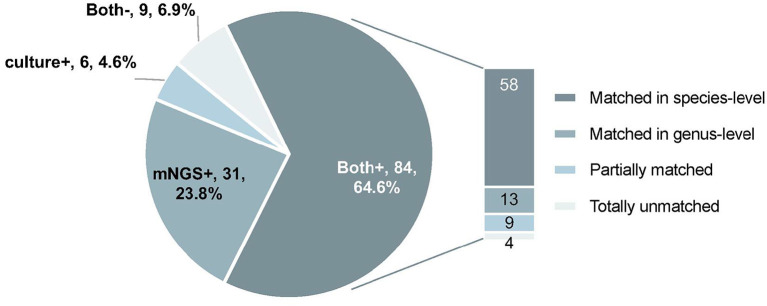
The concordance of results between metagenomic next-generation sequencing (mNGS) and microbiological culture. Both+, results of mNGS and culture were both positive; Both–, results of mNGS and culture were both negative; mNGS+, only the mNGS result was positive, culture was not; Culture+, only the culture result was positive, mNGS was not.